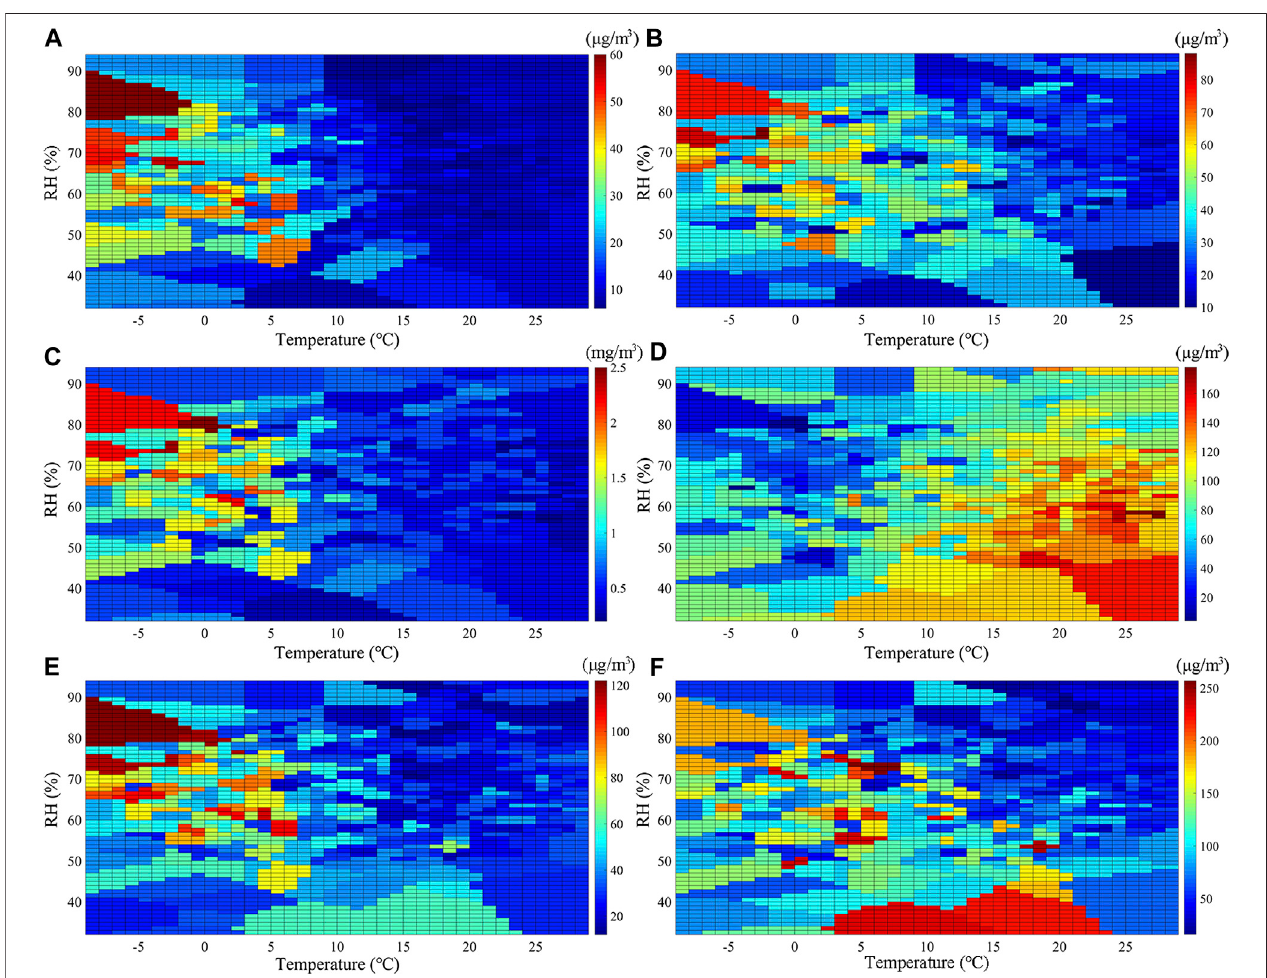
FIGURE 5 | Relation of pollutant concentrations to temperature and relative humidity. (a) SO 2 . (b) NO 2 . (c) CO. (d) O 3 . (e) PM 2.5 . (f) PM 10 .